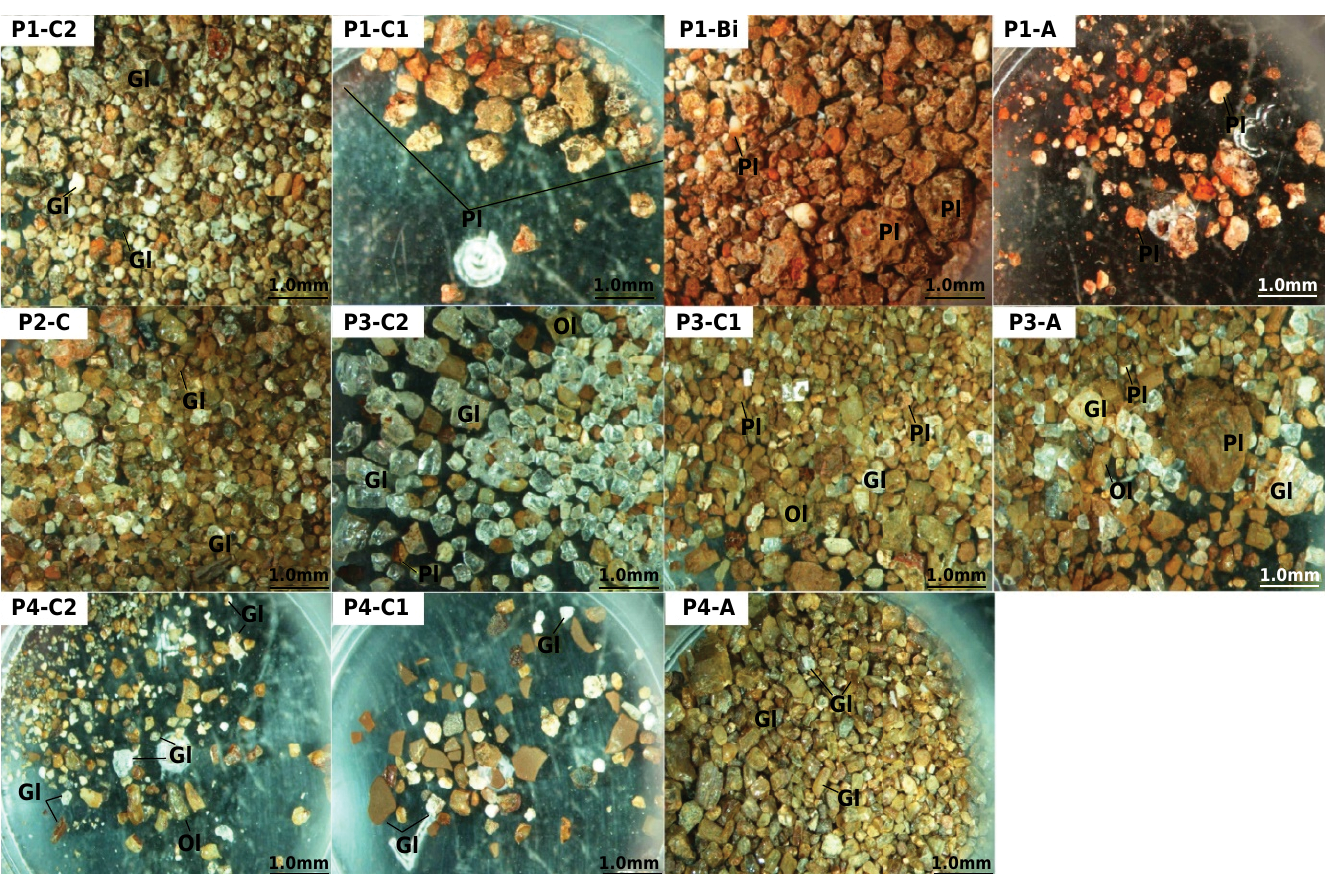
Figure 2. Glass volcanic of light-yellow color in the coarse sand of P1, P2, P3, and P4. It is noted than the amount of palagonitized volcanic glass increases in all horizons of P1 and, in C1 and A of P3. Gl: volcanic glass; Pl: palagonite: Ol: